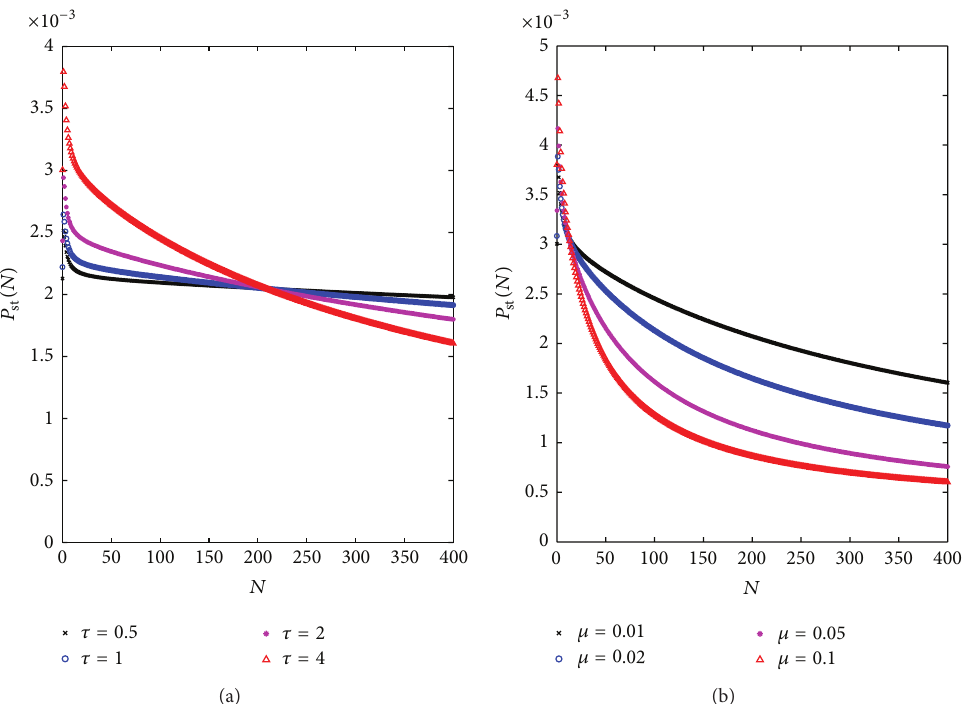
(𝑁) is plotted as a function of 𝑁 when 𝜏 and 𝜇 are varied. st